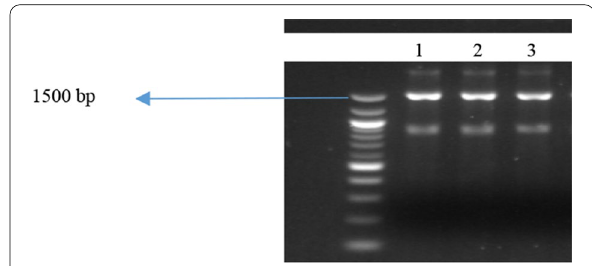
Fig. 1 PCR products of 16S rRNA (Line 1 Line 3 =